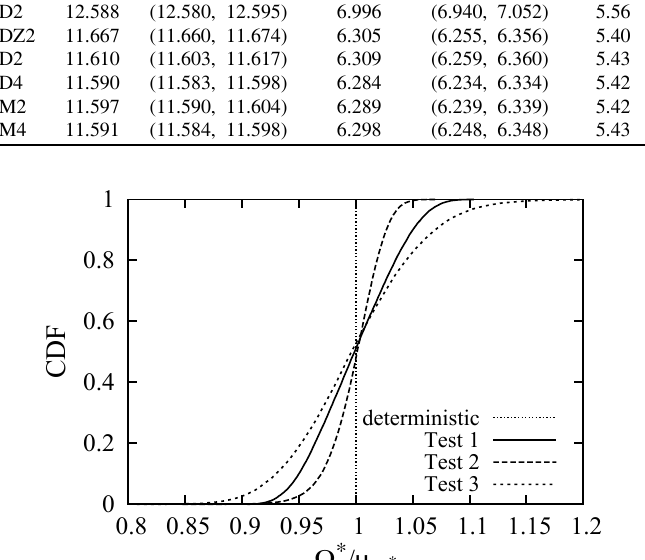
Fig. 7. Cumulative Distribution Function for the symmetric laminate, second material, a 0 /h 0 = 10, tests 1, 2, and